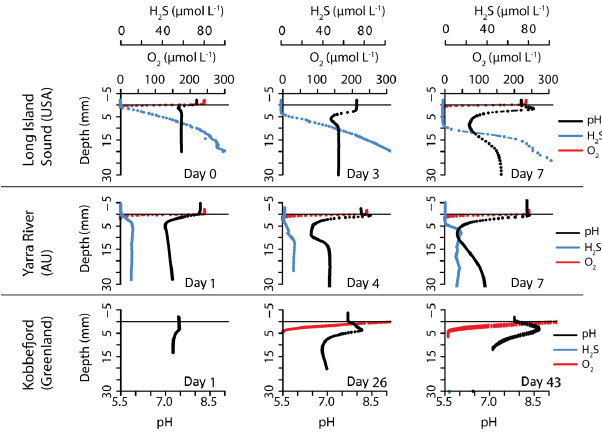
Figure 6. Microsensor depth profiles from laboratory incubation ex- periments within three widely different climatic regions. Sediments were profiled at regular time intervals during incubation. Top row: sediment from Long Island Sound (New York, USA) showed the characteristic pH excursions of e-SOx after 7 days of incubation. Middle row: sediment from the Yarra River (Melbourne, Australia) showed cable bacteria activity after 4 days of incubation. Bottom row: sediment from Kobbefjord (Nuuk, Greenland) showed the pH fingerprint of cable bacteria activity after 26 days of incubation.